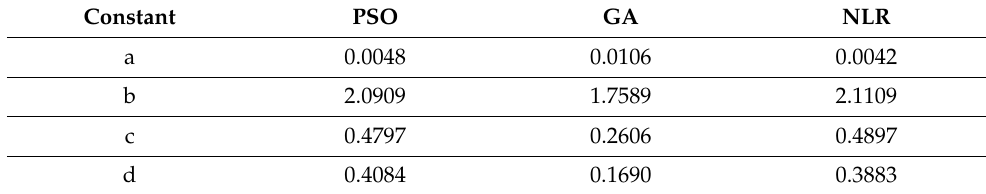
Table 3. Values of unknown constants found by PSO, GA, and NLR for MAP estimation. Constant